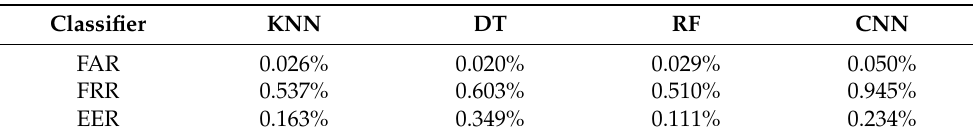
Table 14. AD evaluation—Scenario C (set of mouse movement and point-and-click actions): FAR, FRR, and